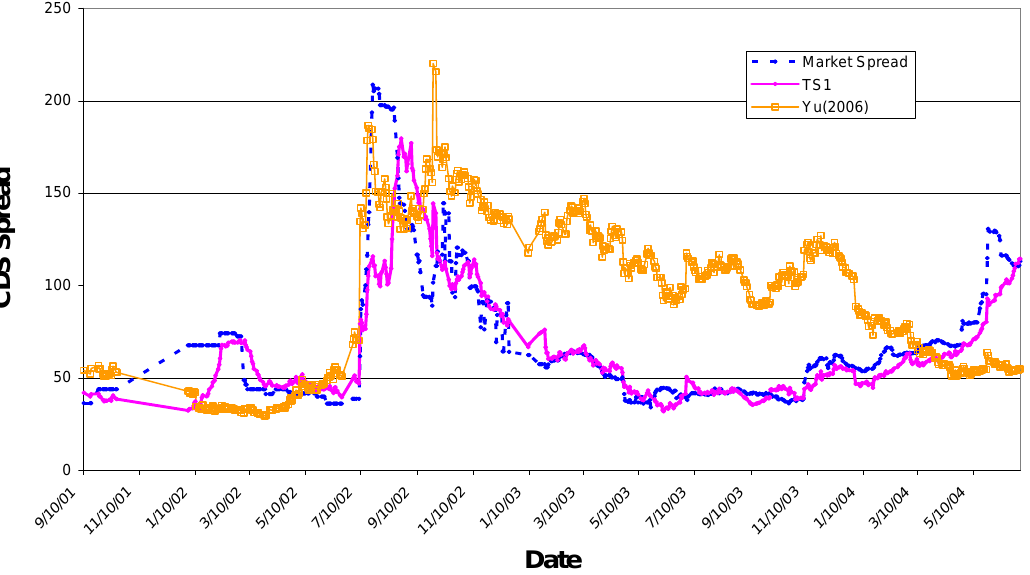
Figure 1. Wyeth, CDS spread, TS1 vs. TS0. Figure 1 presents the market CDS spread, modeled CDS spread computed with methods in Yu [27], and CDS spread computed with TS1. It is shown that TS1 has a much tighter fit than Yu [27].